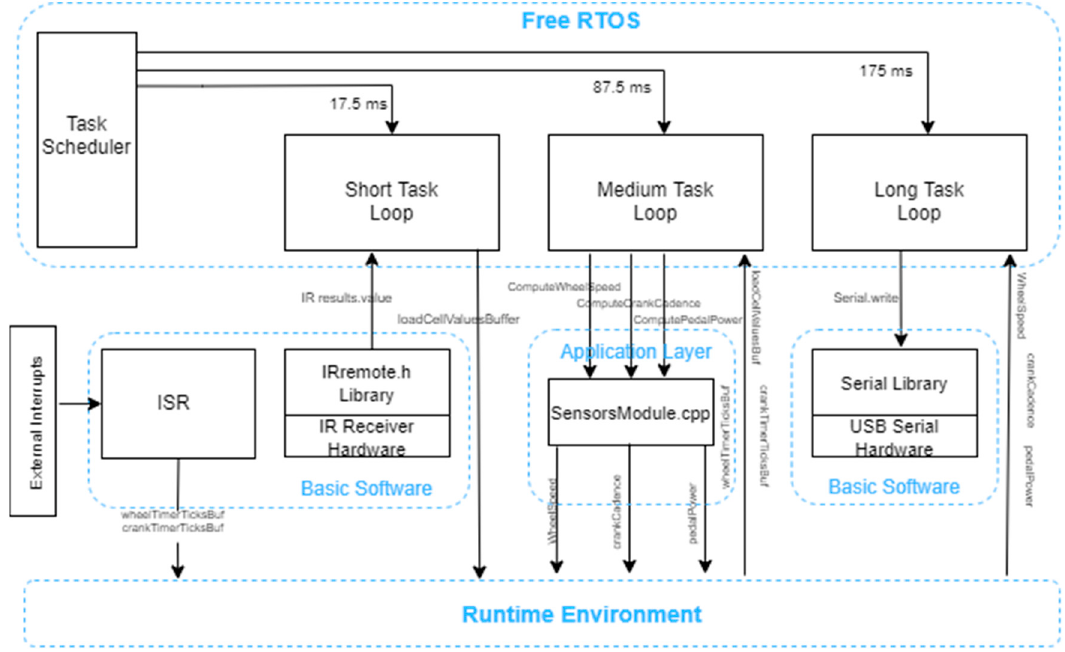
Figure 6. Software architecture.